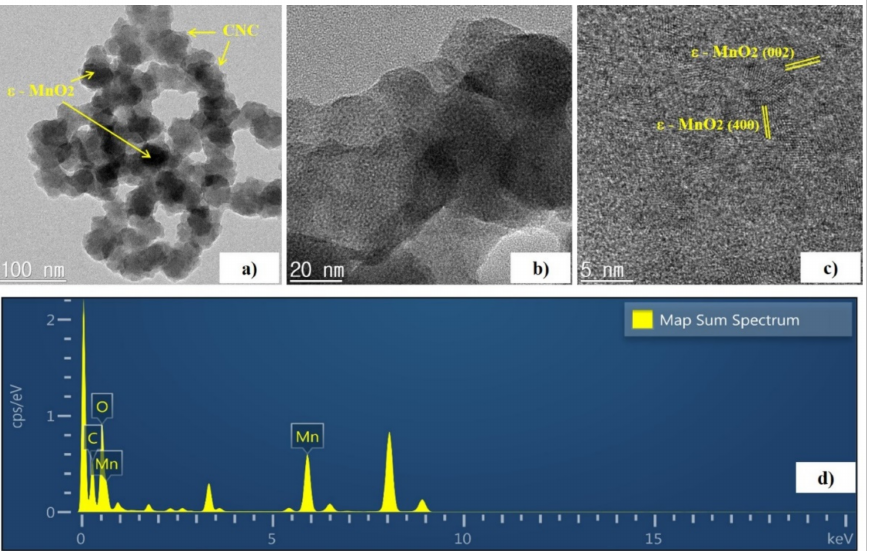
Figure 6. ( a ) Typical, ( b , c ) high-magnification TEM images and ( d ) EDX pattern of MnO 2 -CNC nanocomposite.